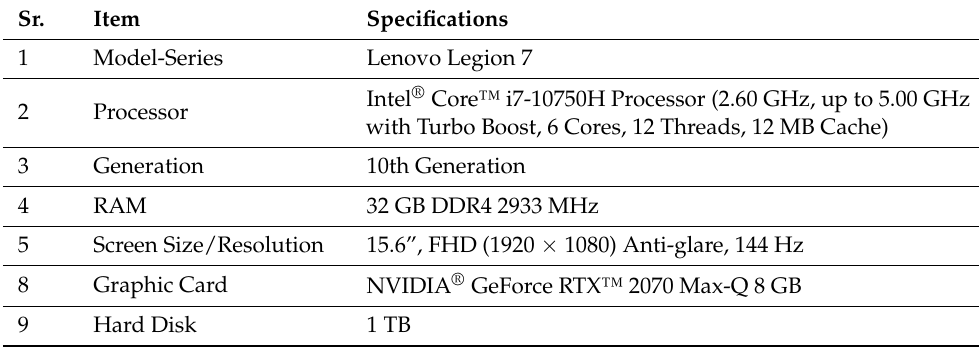
Table 4. GPU Supported Computing Machine Specifications used for Experiments.